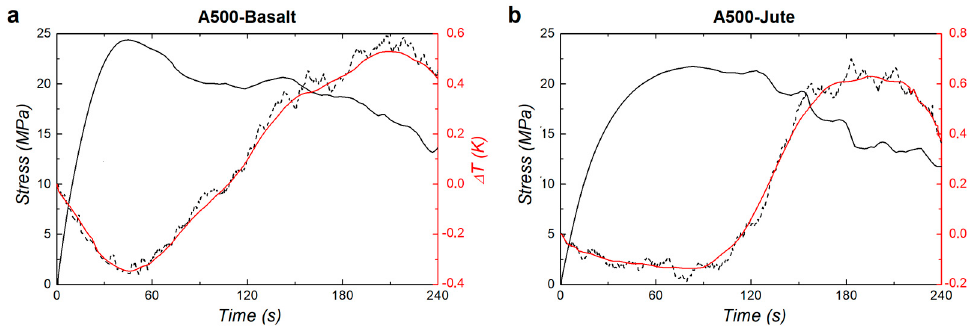
Figure 3. Examples of mechanical and thermal response recorded on the samples analyzed: A500- Basalt ( a ) and A500-Jute ( b ).